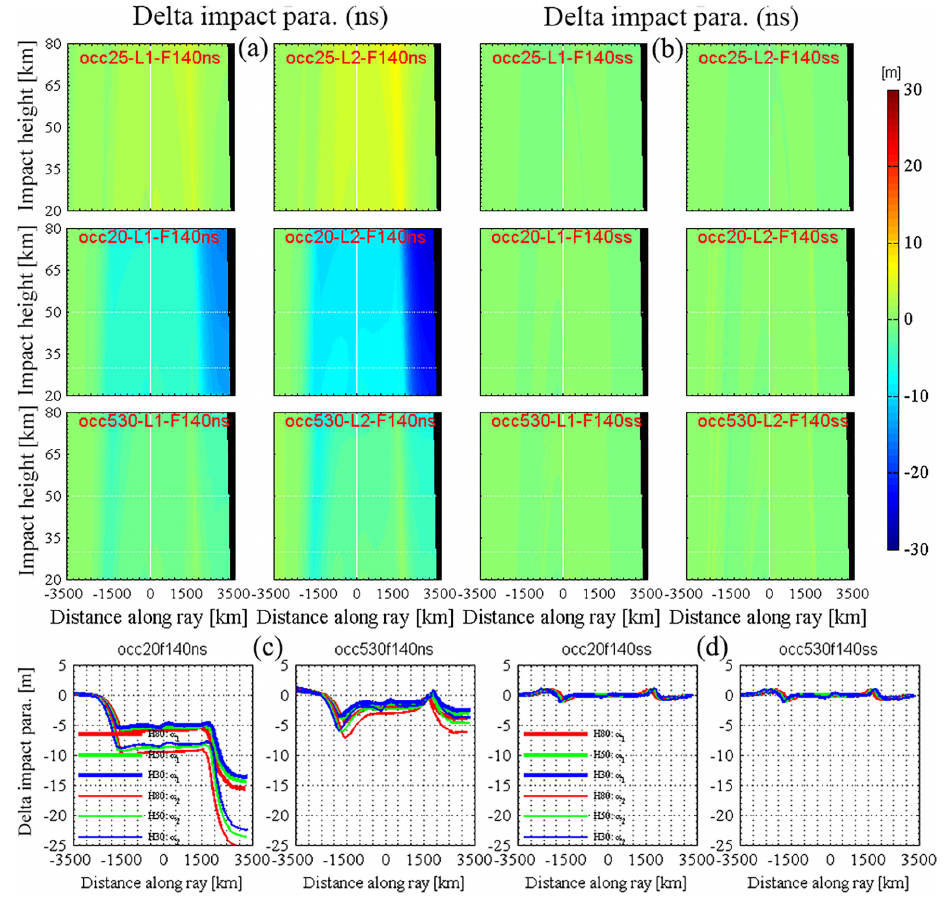
Figure 5. Images of the delta impact parameter (Eq. 3) in the along-ray distance (relative to tangent point) vs. impact height coordinate system for non-spherical-symmetry (a) and spherical symmetry (b) ionospheric conditions, for medium solar activity (F10.7 = 140) and for the GPS frequencies L1 (left sub-panels) and L2 (right sub-panels) for the three representative events (Occ.25, top sub-panels; Occ.20, middle sub-panels, Occ.530, bottom sub-panels). The narrow black stripe visible in the images near the right margin (3500km along-ray distance) is space above the LEO height (reached at around 3250km). The bottom row depicts the corresponding along-ray behavior of the delta impact parameter at three representative impact heights (red, 80km; green, 50km; blue, 30km) for non-spherical (c) and spherical (d) ionospheric conditions, for the Occ.20 (left sub-panels) and Occ.530 (right sub-panels) event. The sub-panel titles (red in a and b , black on top of c and d ) identify the individual cases by a concise